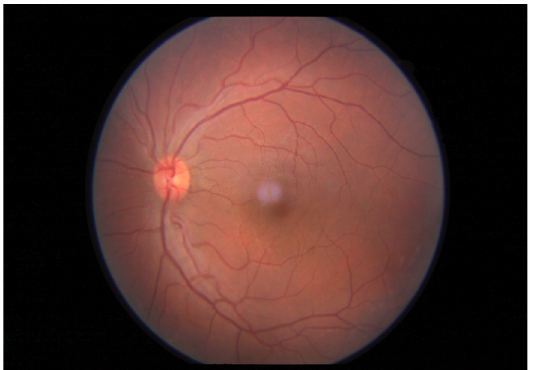
Fig. 2. Normal fundus of the left eye